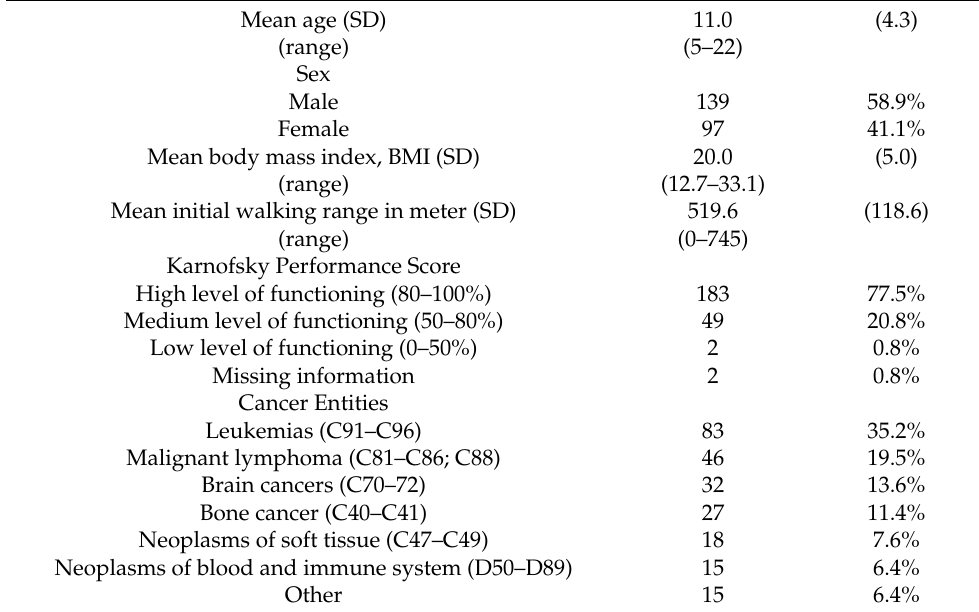
Table 2. Patient characteristics pediatric oncological rehabilitation ( n =